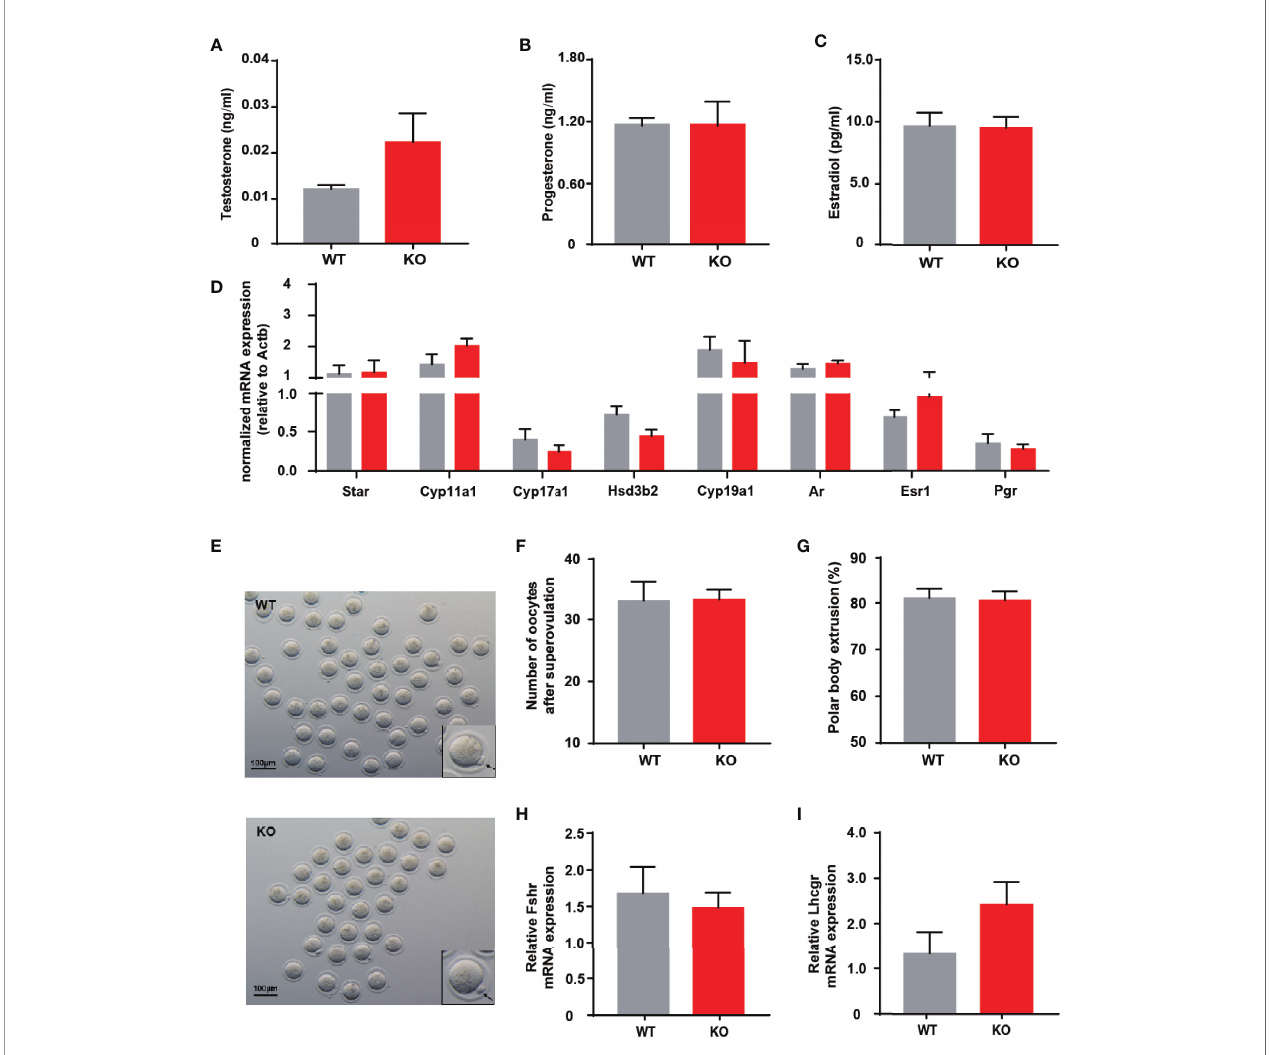
FIGURE 3 | Thada knockout mice have normal ovarian function and ovulation. (A – C) Serum levels of testosterone, progesterone and estradiol of adult female WT and KO mice (n = 9-10). (D) qRT-PCR analysis of hormone related genes in ovary (n = 8-9). (E) Morphology ofMII oocytes, where black arrows indicate polar bodies, scale bar=100 m m.(n = 4-6) (F) Number of oocytes retrieved after ovarian stimulation. (G) Polar body extrusion rates in oocytes from WT and KO mice at adult stage (n = 4-6). (H, I) . mRNA expression of gonadotrophin receptors in ovary(n =